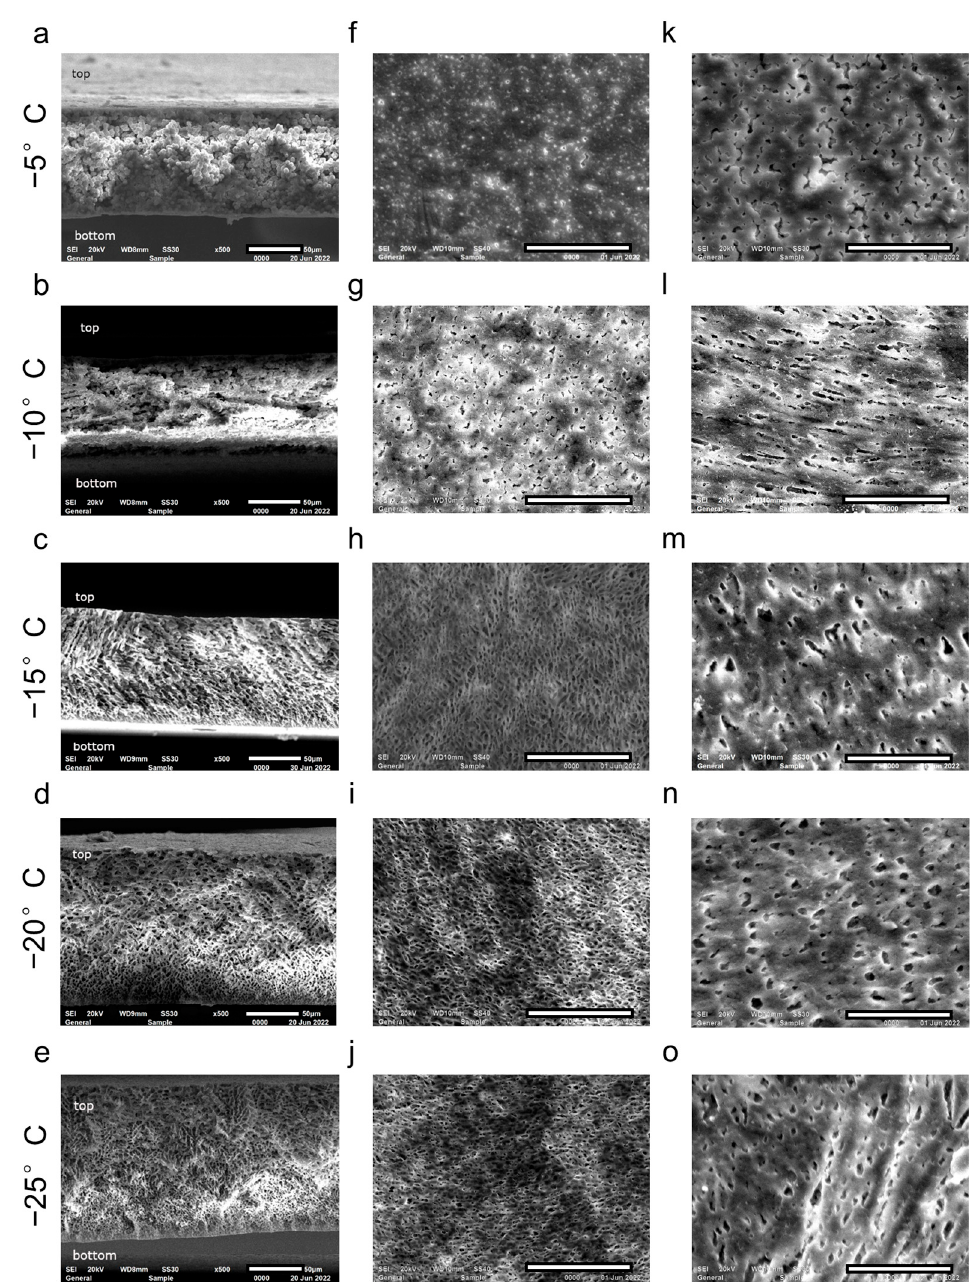
Figure 7. SEM images showing the entire membrane cross-sections ( a – e ), magnified the separation surface of the membrane ( f – j ) and the top surface of the membrane ( k – o ) prepared at different freezing temperatures (the length of the scale bar 50 μ m).